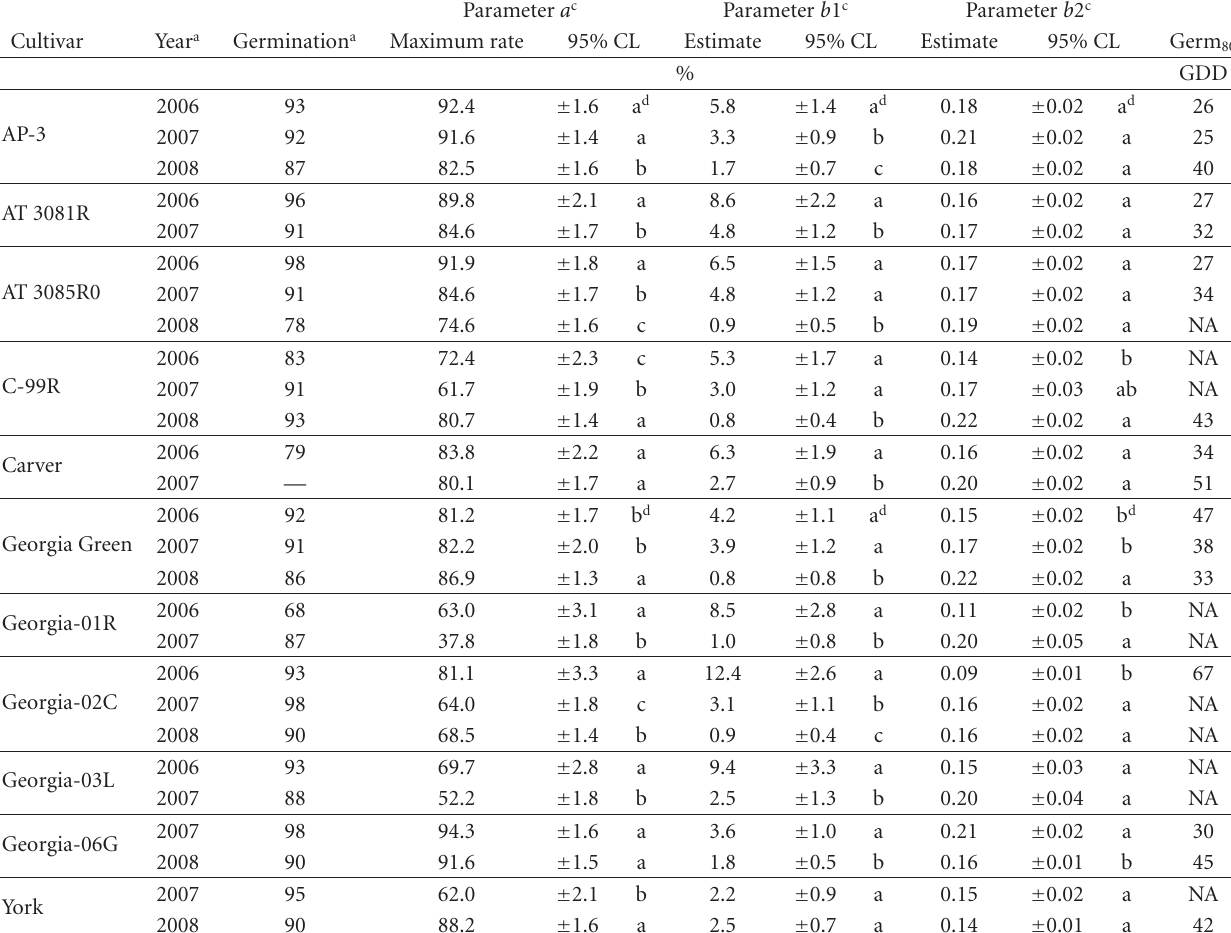
Table 1: Standard Germination a , logistic growth parameter estimates, 95% confidence limits (CL b ), and vigor indices (Germ b 80 ) for germi- nation of seed lots of 11 runner type, and peanut from Georgia using a thermogradient germination